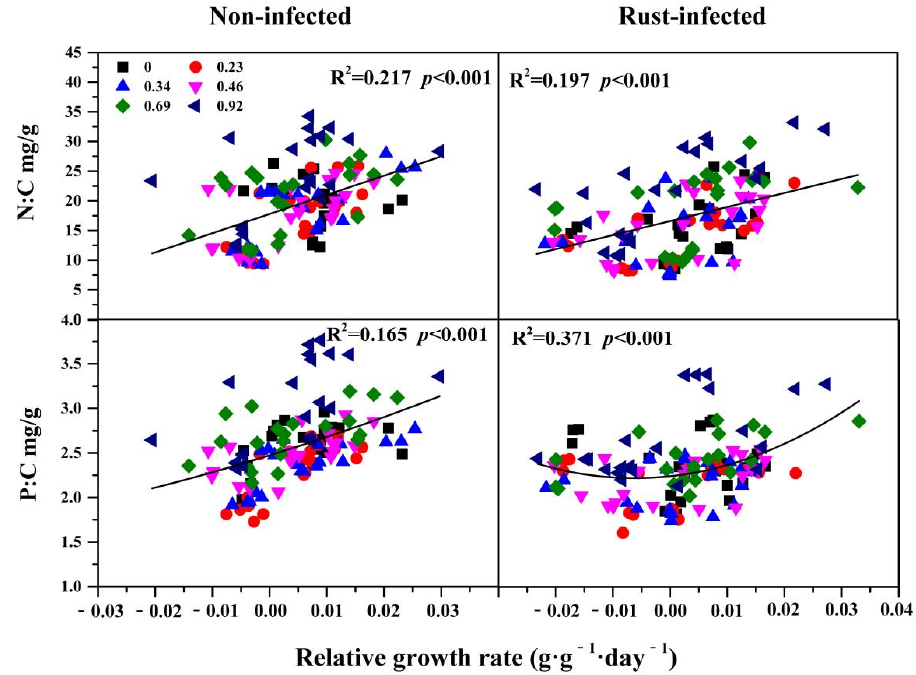
Figure 5. The relationship between relative growth rate and C:N:P stoichiometry of Leymus chinensis (non-infected and rust-infected plants) under different grazing intensities. Grazing intensities (0, 0.42, 0.63, 0.83, 1.25, and 1.67 cattle ha −1 ) are indicated by different colors.